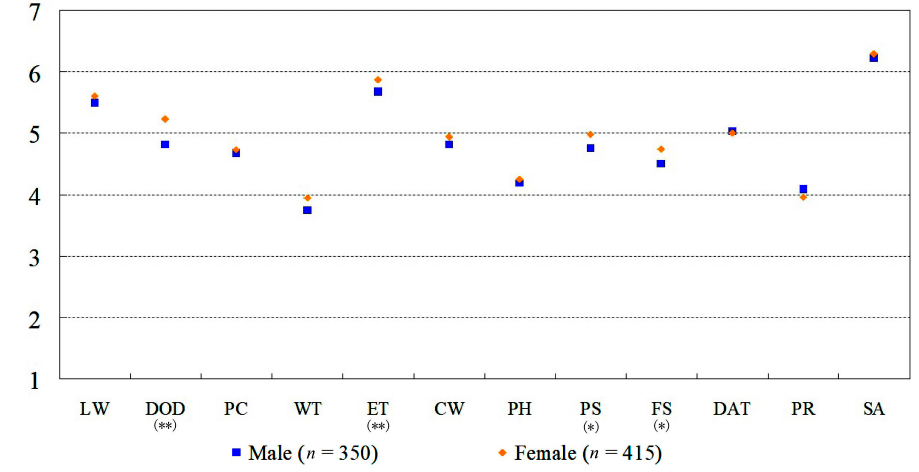
Figure 3. Choice preferences based on sex. LW: Landscape the visitor wants to see; DOD: Degree of difficulty; PC: Pavement condition; WT: Watch the forest train; ET: Experience the forest bath; CW: Contact with landscape elements; PH: Photography; PS: Physical strength; FS: Facility status; DAT: Distance and time; PR: Privacy; SA: Satisfaction. ** Significant at the 0.01 level. * Significant at the 0.05 level.